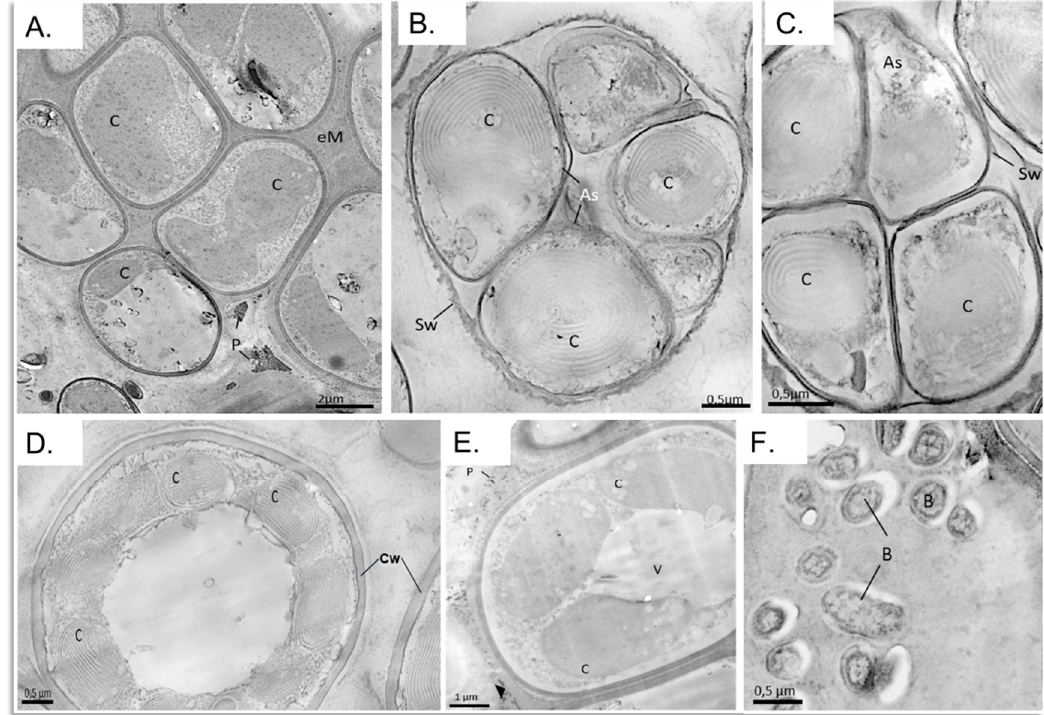
Figure 8. Electron microscopic analysis of a section through a sample taken from the fumarole biofilm SP5. An overview of a Cyanidiales cell aggregate ( A ). Sporangia (mother cells; B , C ) containing a varying number of autospores. In three of the five autospores ( B ), the membrane stacks of the thylakoids in the chloroplasts are clearly visible. Within the mother cell ( C ), four autospores (tetraspores) already are about the same size and the sporangium wall is disintegrating. The cells in ( D,E ) carry multiple chloroplasts around a central vacuole. Both cells could be assigned to the genus Galdieria . Prokaryote morphotypes of about 0.5 μ m in size attached to the Cyanidiales aggregate ( F ). V, vacuole; eM, extracellular matrix; Cw, cell wall; Sw, sporangium wall; B, bacteria; As, autospores; P, precipitates.